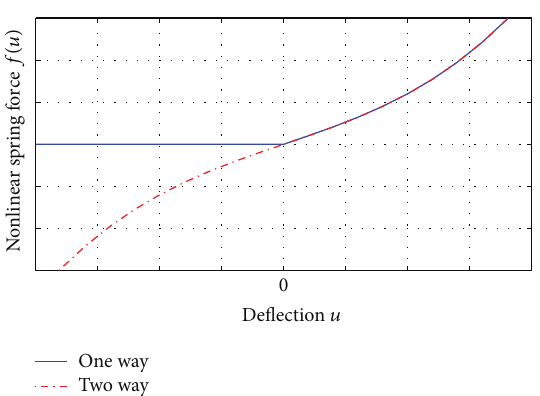
Figure 1: Nonlinear elastic foundation model: a nonlinear spring model (one way) and a conventional one (two way).